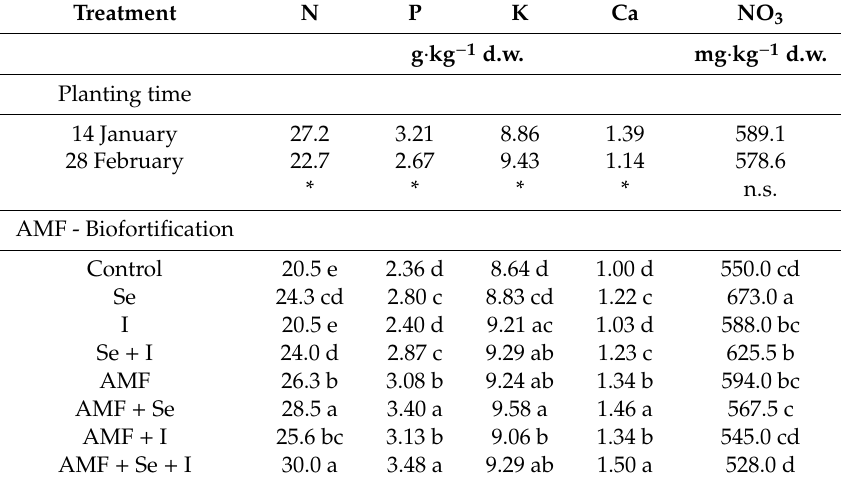
Table 5. Macro-element contents in chickpea seeds as a ff ected by planting time and AMF -